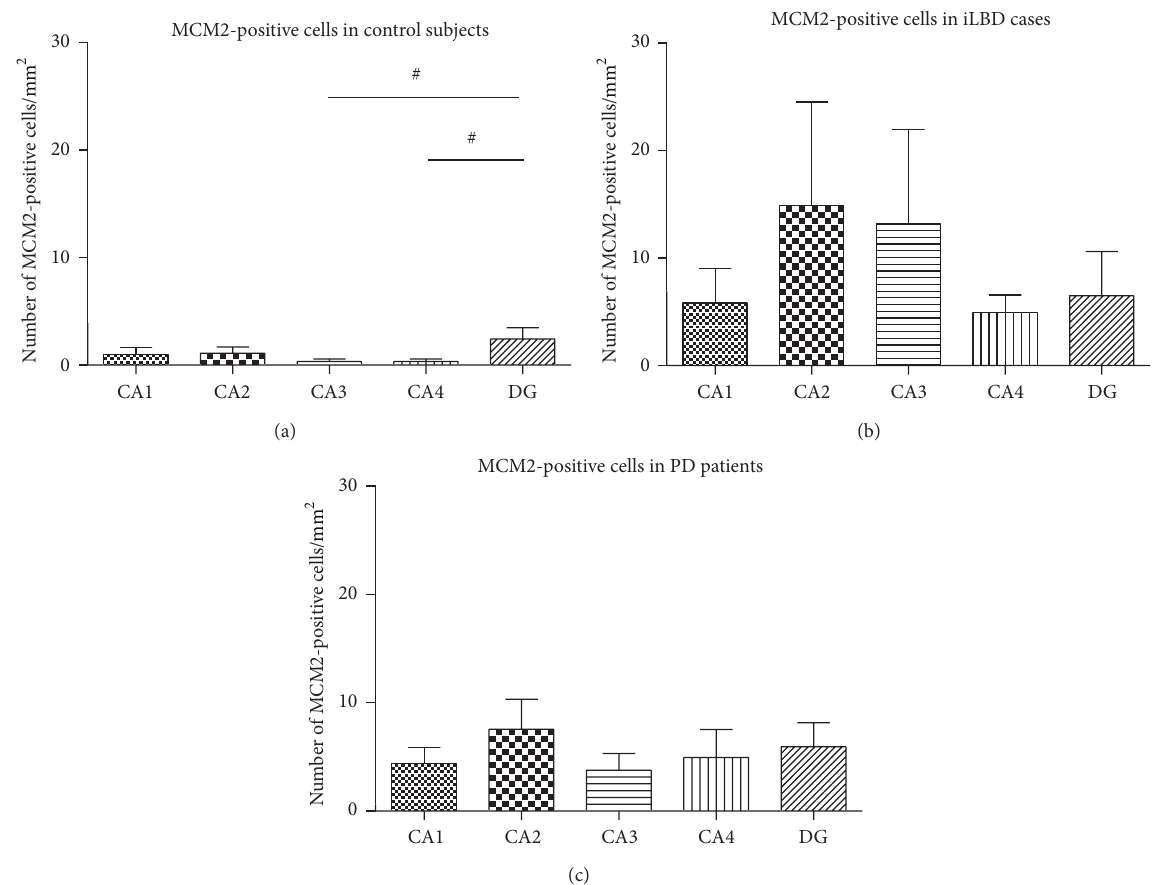
Figure 3: MCM2-positive cell numbers in control subjects, iLBD cases, and PD patients. Semiquantitative analysis revealed that in (a) control subjects, a significant main effect was present ( 𝑃 = 0.034 ; related nonparametric Friedman’s analysis) with higher numbers of MCM2-positive cells in the DG compared to the hippocampal subregions (DG versus CA3 and CA4 # 𝑃 = 0.043 ; DG versus CA1 𝑃 = 0.08 n.s.; DG versus CA2 𝑃 = 0.225 n.s.; nonparametric paired Wilcoxon post hoc test). (b, c) In the iLBD and PD cases, no differences were present between any of the subregions. Significance reached at alpha of 𝑃 ≤ 0.02 , FWE-corrected. Data represent mean ±